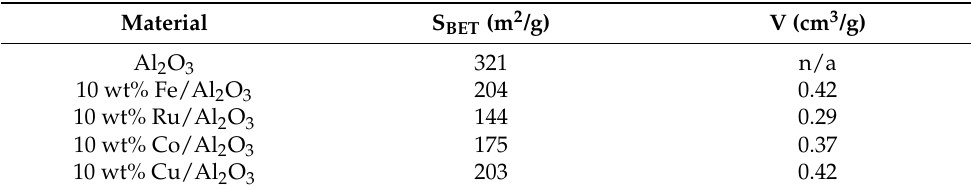
Table 1. Active surface area and pore volume of the different 10 wt% Al 2 O 3 -supported metal catalysts, as well as the pristine Al 2 O 3 .